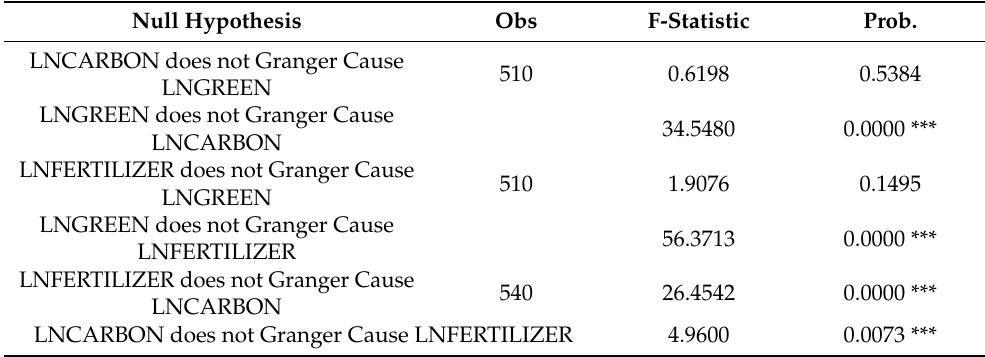
Table 9. Pairwise Granger causality